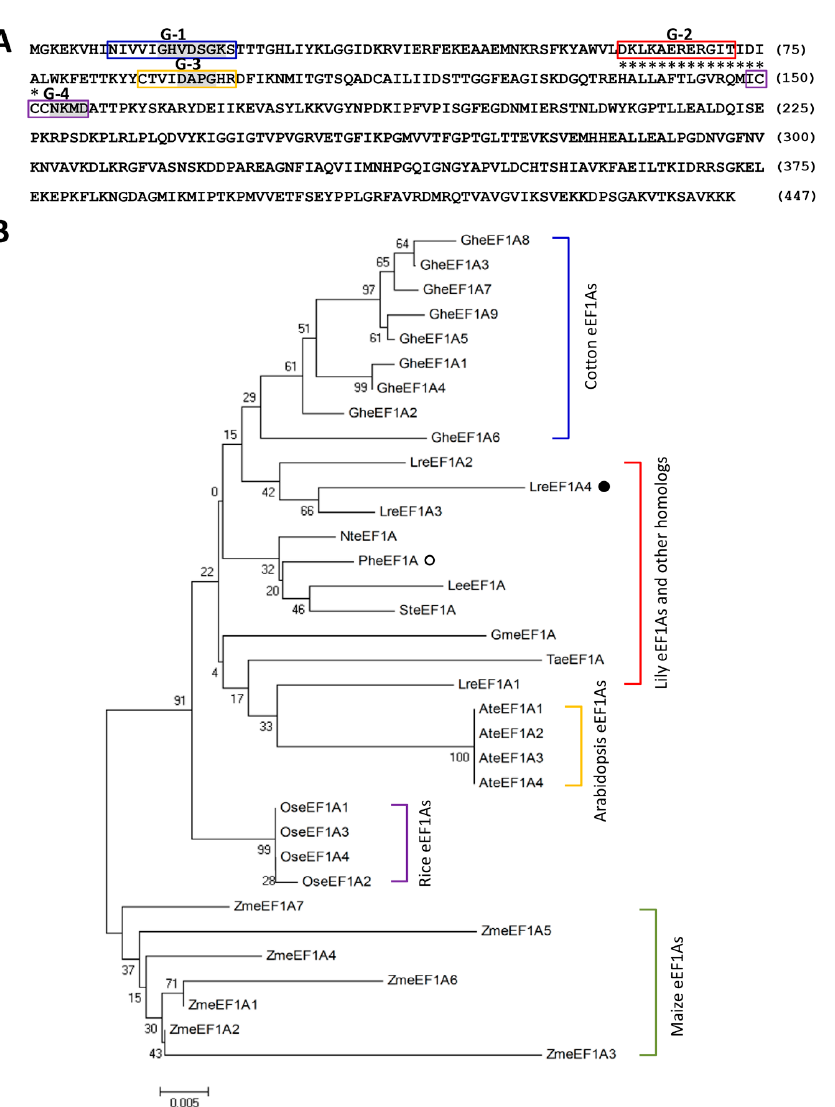
Figure 1. Amino acid and phylogenetic analysis of LreEF1A4. ( A ) Deduced amino acid sequence of LreEF1A4 from Lilium regale . The central regions (G-1 to G-4) involved in guanosine 5 ′ -diphosphate/ guanosine 5 ′ -triphosphate (GDP/GTP) exchange and GTP hydrolysis are boxed in blue, red, orange, and purple, respectively. The conserved three elements GXXXXGK (G14–K20), DXPG (D91–G94), and NKXD (N153–D156) in the GTP-binding domain are shaded in grey. Asterisks indicate the GTP-binding elongation factor signature. ( B ) Phylogenetic tree of LreEF1A4 with three other L. regale LreEF1As, Petunia hybrida PheEF1A (Peaxi162Scf00351g00321, Sol Genomics Network database), Lycopersicum esculentum LeeEF1A (P17786), Solanum tuberosum SteEF1A (XP_006340223), Nicotiana tabacum NteEF1A (XP_016492900), Glycine max GmeEF1A (P25698), Triticum aestivum TaeEF1A (AQU14666), Arabidopsis AteEF1A1 (At1g07920), AteEF1A2 (At1g07930), AteEF1A3 (At1g07940), and AteEF1A4 (At5g60390), Oryza sativa OseEF1A1 (BAA23657), OseEF1A2 (BAA23658), OseEF1A3